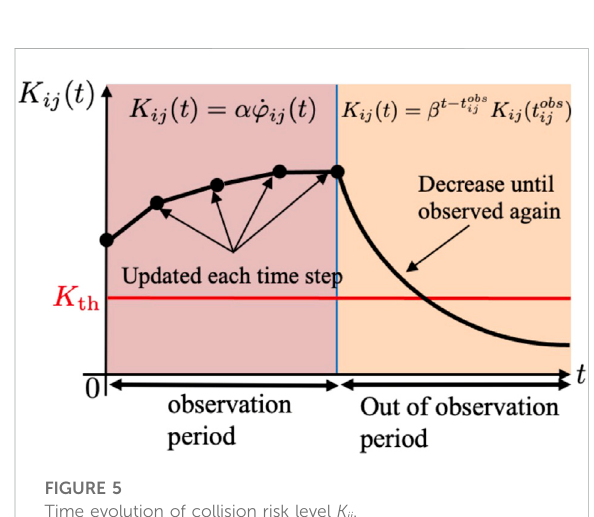
FIGURE 5 Time evolution of collision risk level K ij .